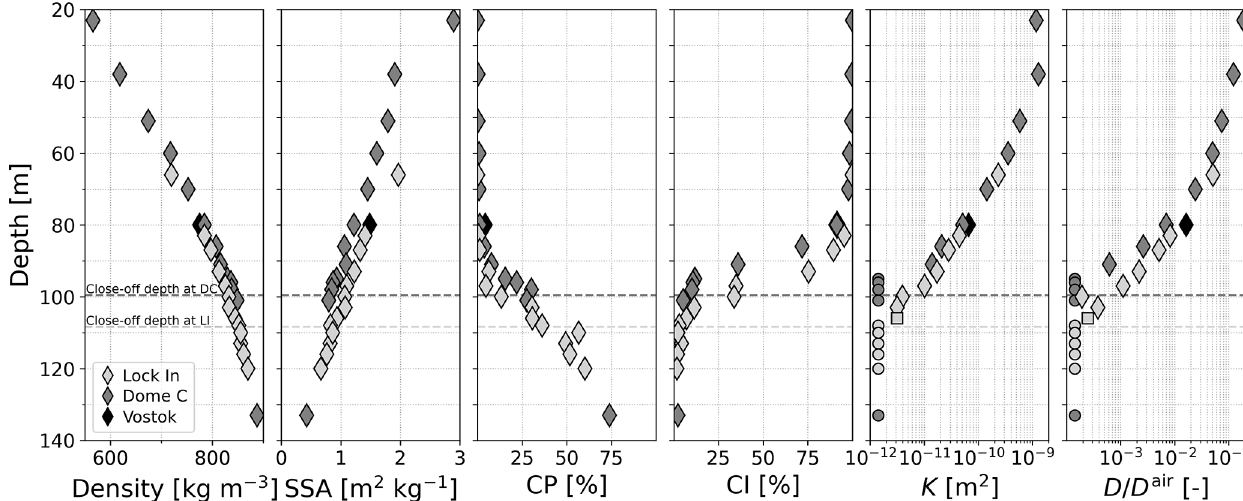
Figure 1. Evolution of firn properties with depth: density, specific surface area, closed-to-total porosity ratio, connectivity index, averaged permeability, and averaged effective coefficient of diffusion (from left to right). Dashed lines show the close-off depth at Dome C (dark grey) and Lock In (light grey) from Burr et al. (2018). Circle symbols indicate values of permeability and effective diffusion equal to zero. Square symbols show a Lock In sample (106m depth) with horizontal components of the transport properties equal to zero and correspond thus to the values of the vertical component